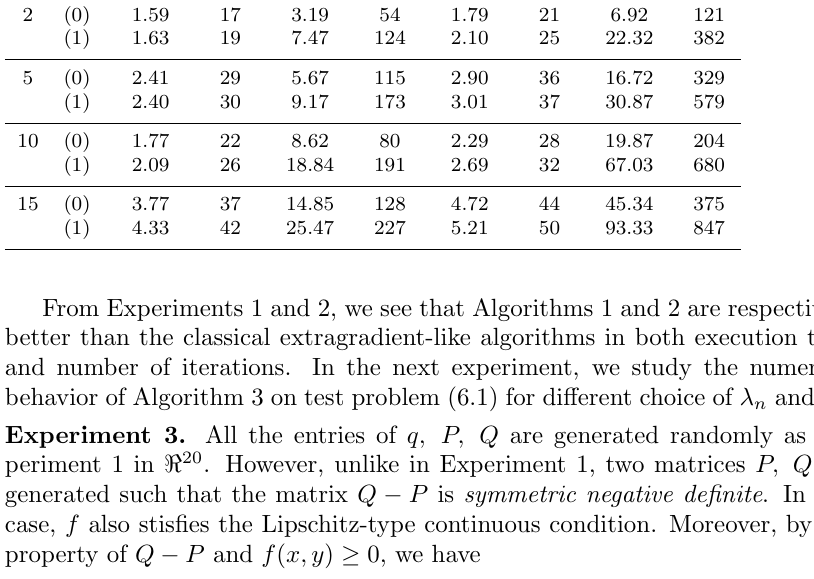
Table 2. The results for Algorithm 2 and VEGM in Experiment 2 α Algorithm